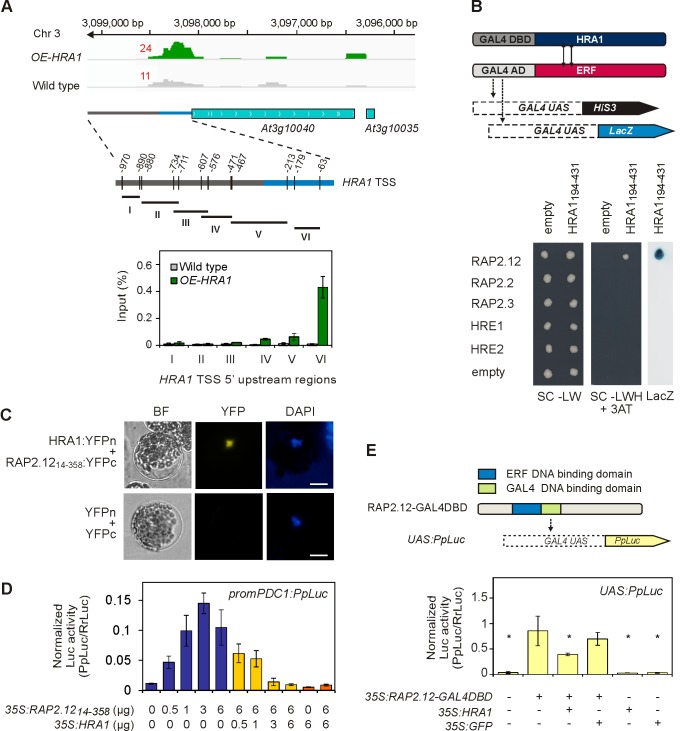
HRA1 modulates transcription of anaerobic genes through protein–protein interaction with RAP2.12.(A) HRA1 binding site on the upstream region of the HRA1 gene. The number next to the peak indicates the peak summit. ChIP-seq peak area for HRA1 was subsequently divided into six regions for confirmation of DNA binding using ChIP-qPCR (see Table S4 for primer sequences). TSS, transcription start site. (B) Yeast-two-hybrid assay between an HRA1 C-terminal fragment (HRA1194–431) and the five Arabidopsis ERF-VII proteins. AD, activation domain; DBD, DNA binding domain; UAS, upstream activating sequence. SC-LW, control medium −Leu −Trp; SC-LWH+3AT, selective medium −Leu −Trp −His +3AT; LacZ, β-galactosidase assay. (C) Bimolecular fluorescence complementation between HRA1 and RAP2.12 in Arabidopsis mesophyll protoplasts. DAPI staining indicates the position of the nucleus. Scale bar, 20 µm. (D) Transcriptional activation of the PDC1 promoter, visualized through a firefly luciferase (PpLuc) reporter fusion, by RAP2.12 alone (blue bars) and in combination with HRA1 (yellow bars) or its C-terminal fragment HRA1194–431 (orange bars). Data are mean ± s.d. (n = 4). (E) Dual luciferase assay showing that HRA1 repression of RAP2.12 is independent of HRA1 binding to DNA. A heterologous promoter made up of four repeats of the yeast GAL4 upstream activating sequence (“GAL4 UAS”) was introduced into plant protoplasts and could only be recognized by chimeric GAL4DBD (GAL4 DNA binding domain)-containing TFs, in this case by RAP2.12-GAL4DBD [7]. GFP was used as a negative control, as a RAP2.12 noninteracting protein. Data are mean ± s.d. (n = 3); *p<0.05, statistically significant difference from the positive interaction produced by RAP2.12-GAL4DBD.